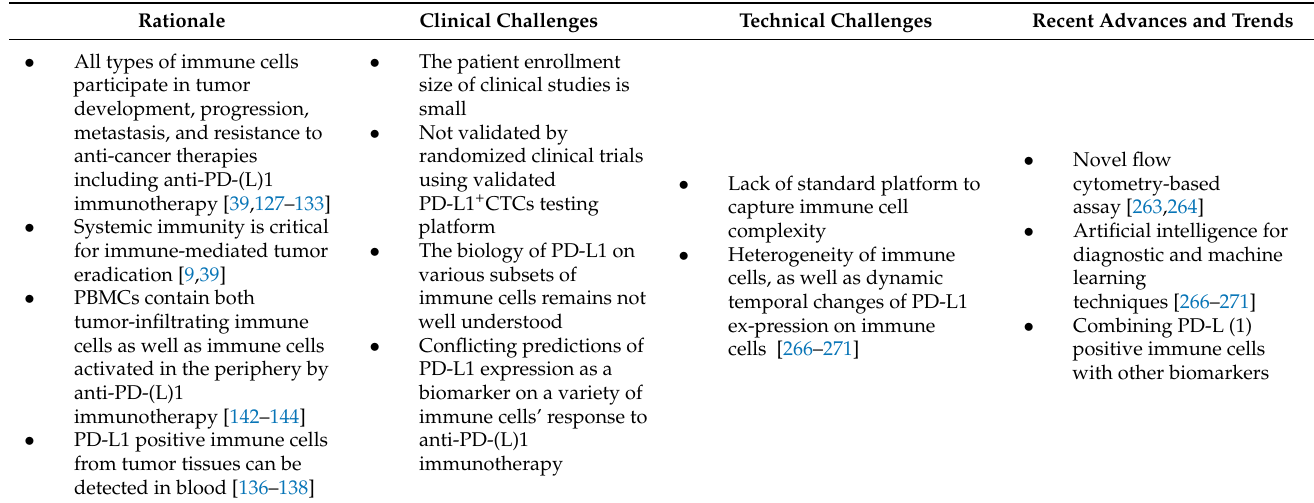
Table 2. Clinical and technical challenges in the use of PD-L1-positive circulating immune cells as a biomarker for anti-PD-(L)1